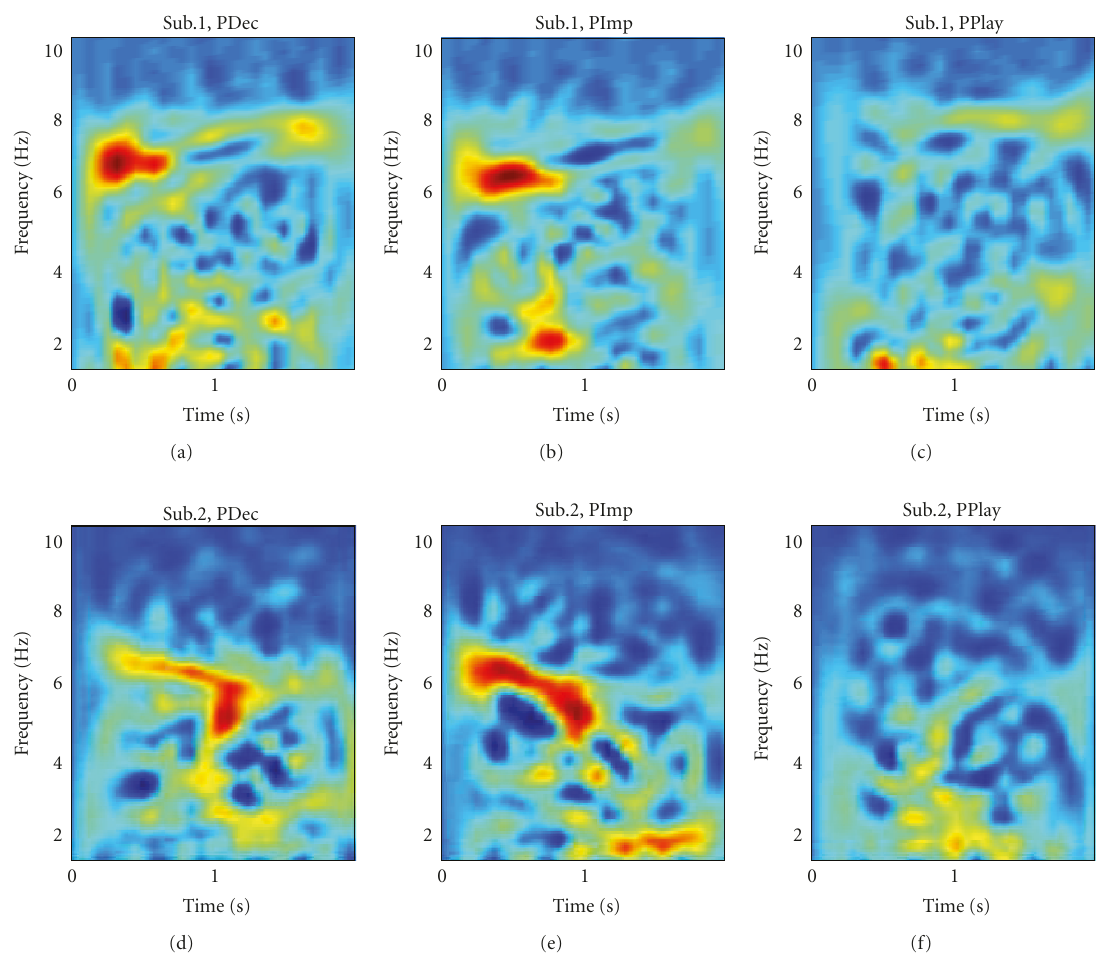
Figure 9: Multitaper spectrogram estimation of induced potentials from Protodeclarative (PDec), Protoimperative (PImp) and neutral parallel play (PPlay) shows, using N = 256, F s = 12, c = 1 . 1, and δ = 0 . 05. The number of averaged power responses are for subject 1, 20 and for subject 2,